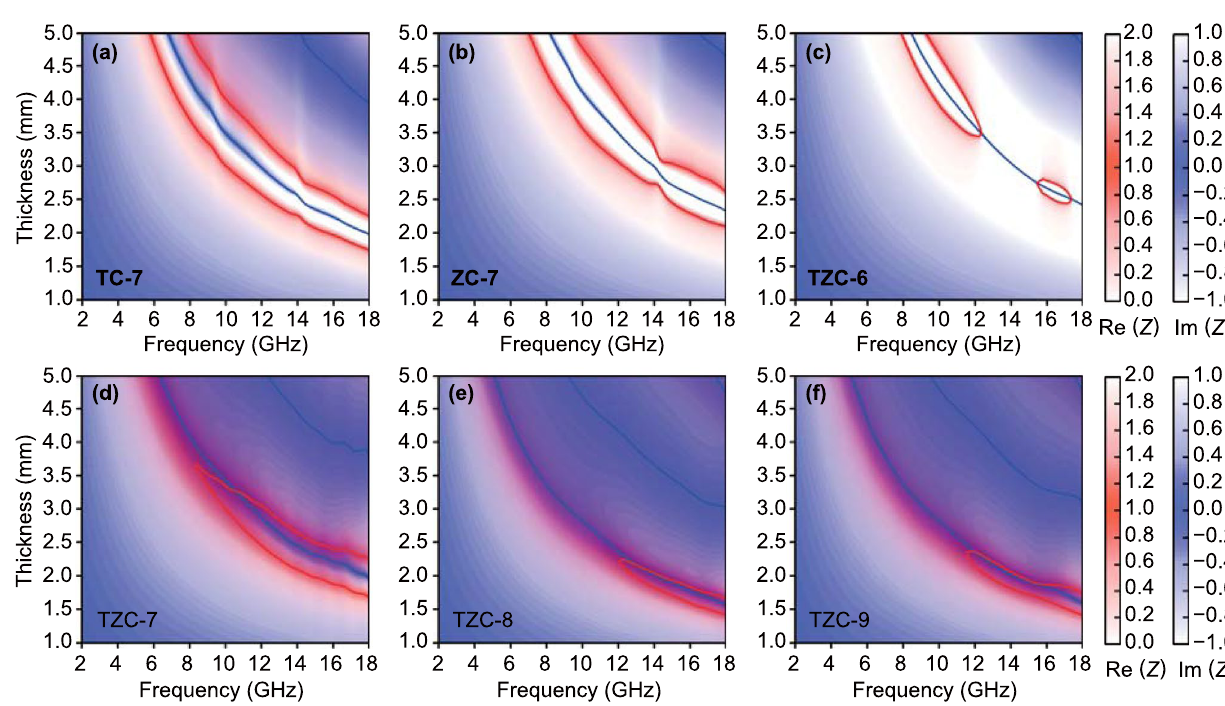
Fig. 7 Two-dimensional projection drawings of ( Re ( Z )) and ( Im ( Z )) values versus thickness and frequency for a TC-7, b ZC-7, c TZC-6, d TZC-7, e TZC-8, and f